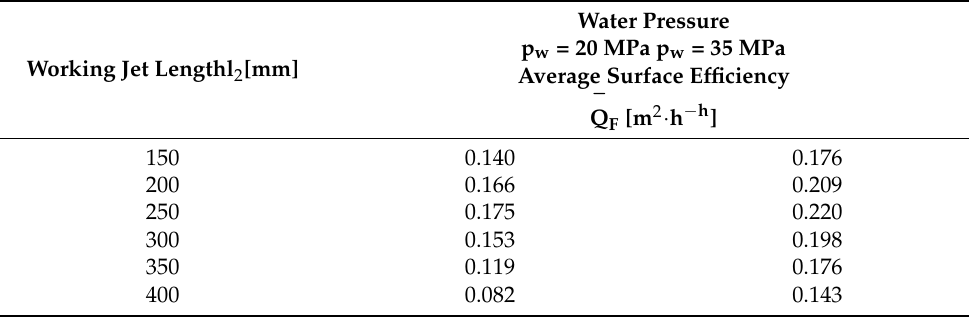
Table 16. Measuring results of average surface paint coat stripping efficiency Q F [m 2 · h − 1 ] of the PA2 aluminium alloy specimen depending on the working length of the spray l 2 [mm].